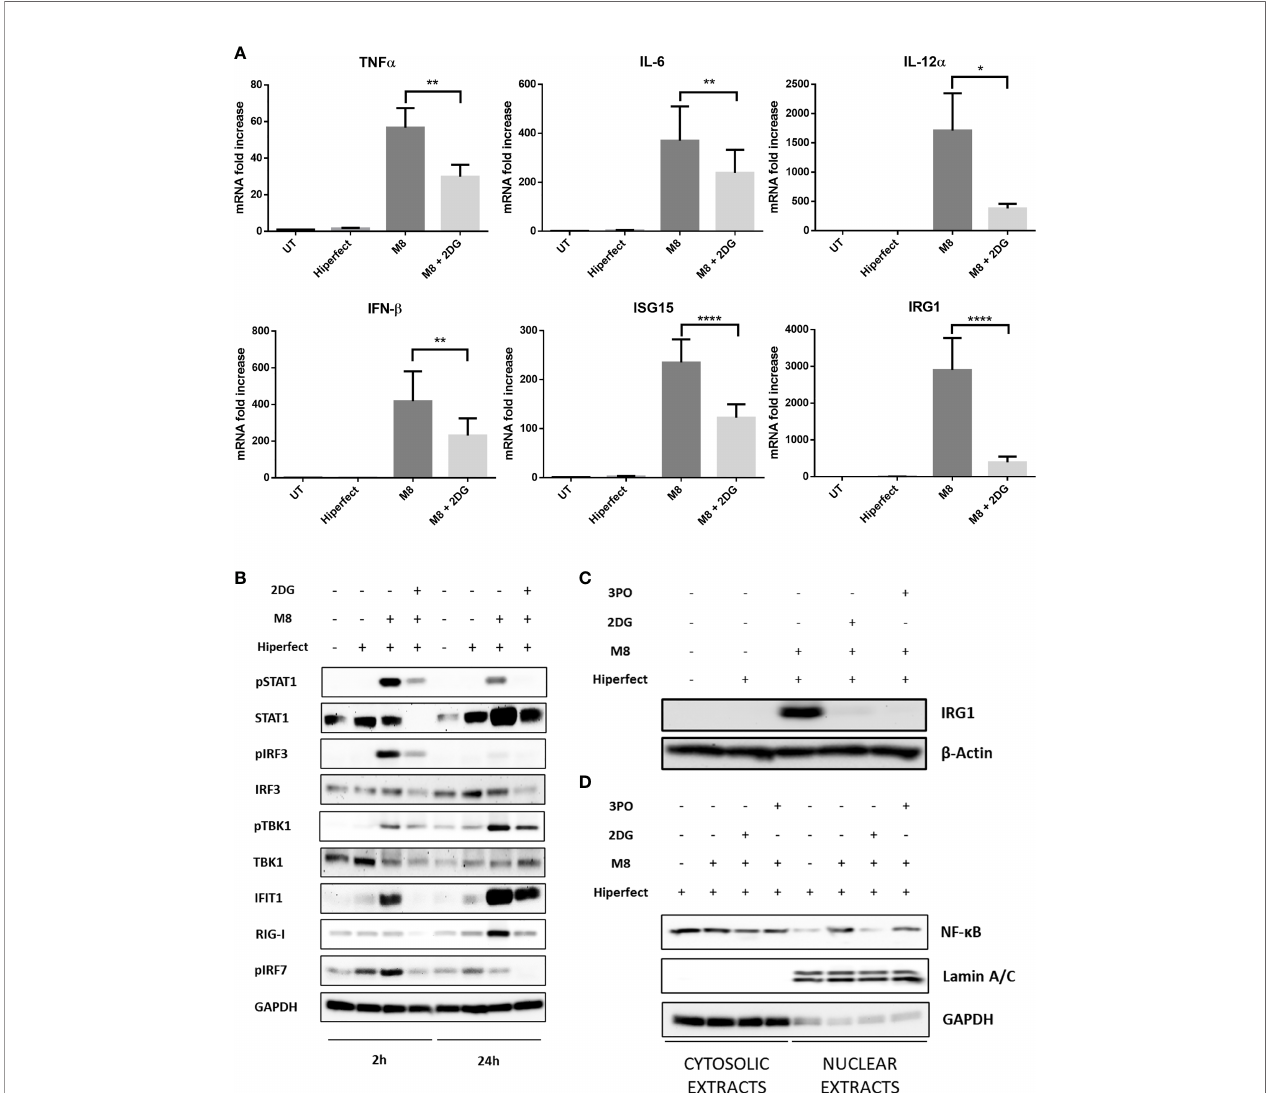
DC FIGURE 4 | M8 requires active glycolysis to trigger type I interferon (IFN) and nuclear factor k B (NF- k B) responses in monocyte-derived dendritic cells (MoDCs). (A) Gene expression levels of IFN- b , ISG15, IRG1, IL-12, IL-6, and TNF a in MoDCs were quanti fi ed by qPCR after 1h treatment with or without 2-deoxyglucose (2- DG) (6 mM) and 6h treatment with M8 (50 ng/ml). Results are normalized to the TBP gene and expressed as fold of increase relative to control (UT), set as 1. Data represent means±SEM from fi ve independent experiments. (B) Immunoblot analysis of key components of type-I IFN signaling in MoDCs treated for the indicated hours by M8 alone (50 ng/ml) or pretreated by 2-DG (6 mM) for 1h, normalized on GAPDH expression. Culture medium and HiPerFect alone were used as controls. (C) Immunoblot analysis of IRG1 expression in MoDCs treated for 6h by M8 alone (50 ng/ml) or pre-treated by 2-DG (6 mM) or 3-PO (25 µM) for 1h, normalized